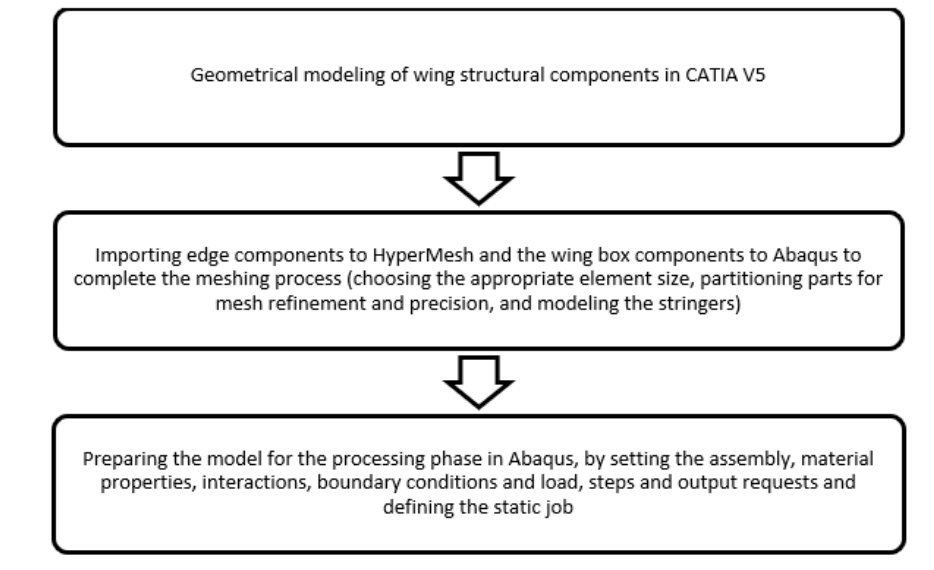
Figure 5. General steps of the preprocessing phase of the analysis.